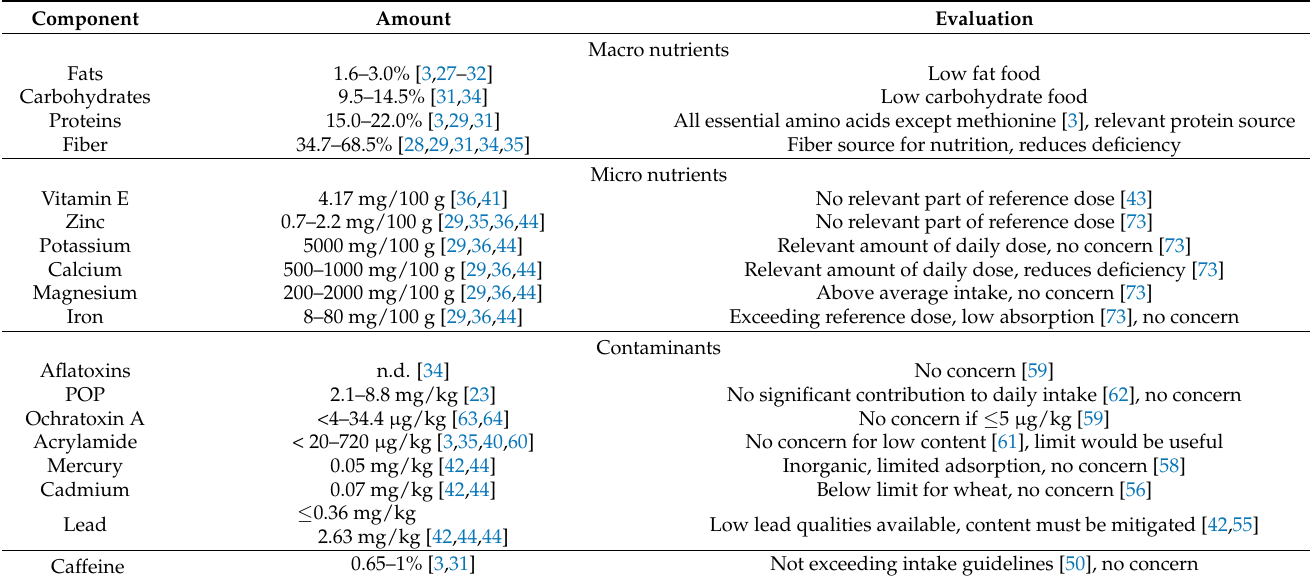
Table 5. Nutritional data for relevant components of silver